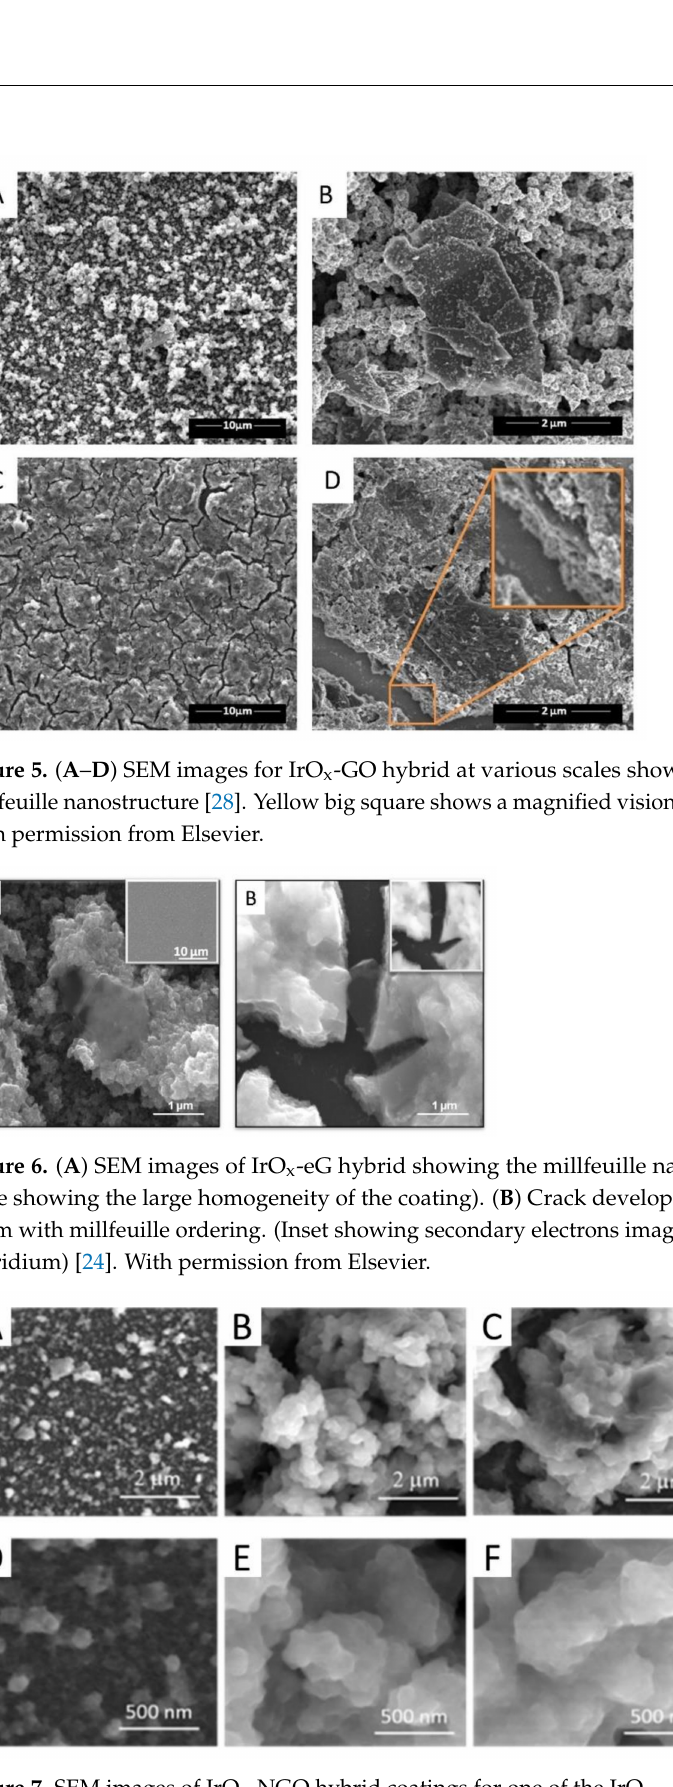
Figure 7. SEM images of IrO x -NGO hybrid coatings for one of the IrO x —NGO hybrid (NGO treated at 100 ◦ C ( A , D ), 220 ◦ C ( B , E ) and 300 ◦ C ( C , F ) [29]. With permission from